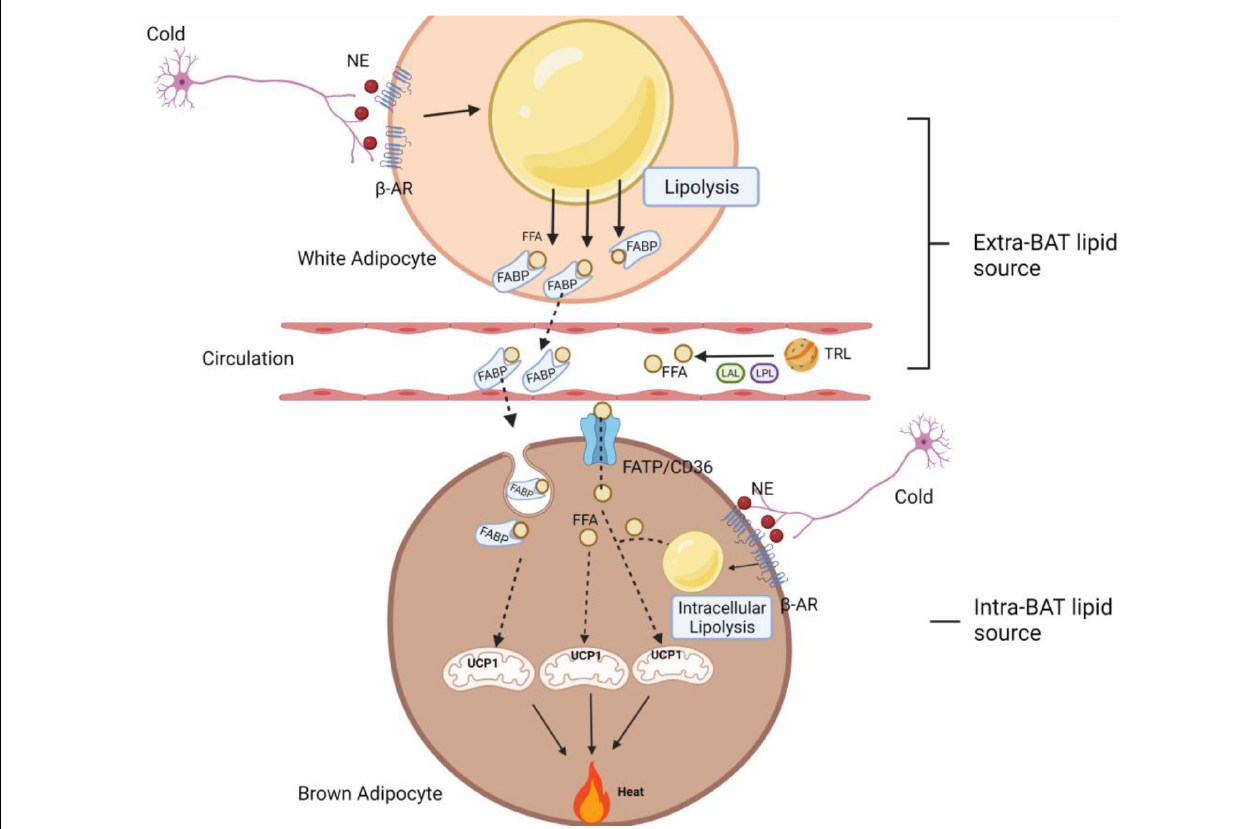
FIGURE 5 | A schematic diagram of fine-tuned lipolysis in thermogenic biology. Upon cold stimulation, the non-shivering thermogenesis process in BAT can be mediated through intra- and extra-BAT FFAs source. In local lipolysis, FFAs generated from brown adipocyte lipid droplets can be used directly to activate and fuel UCP1 to produce heat. In addition, there is also a synergistic and compensatory mechanism, where white adipocyte lipolysis and TRL degradation (with the help of LPL and LAL) serve as extracellular fuels to permit a maximum thermogenesis level. These circulating FFAs are imported into BAT via FABP, FATP1 and CD36 transporters. Among them, FABP assists the binding of FFA released in WAT, which is later imported into brown adipocytes as a FABP-FFA complex via endocytosis. AR, adrenergic receptor; FFA, free fatty acid; NE, norepinephrine; FABP, fatty acid-binding protein; FATP, fatty acid transport proteins; TRL, triglyceride-rich lipoprotein; LPL, lipoprotein lipase; LAL, lysosomal acid lipase; UCP1, uncoupling protein